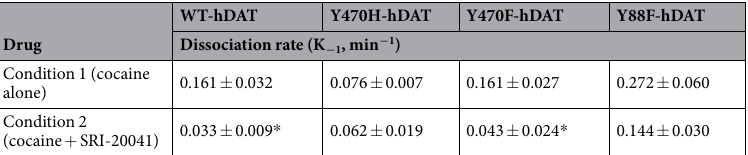
Table 1a). Two-way ANOVA revealed that there were significant main effects of drug (F (1,40) = 14.20, p < 0.01) and mutation (F (2,18) = 6.30, p < 0.01). The dissociation rate in WT-hDAT (K − 1 = 0.161 ± 0.032 min − 1 ) was similar to that in Y470F-hDAT (K − 1 = 0.161 ± 0.027 min − 1 ) and not significantly changed in Y88F-hDAT